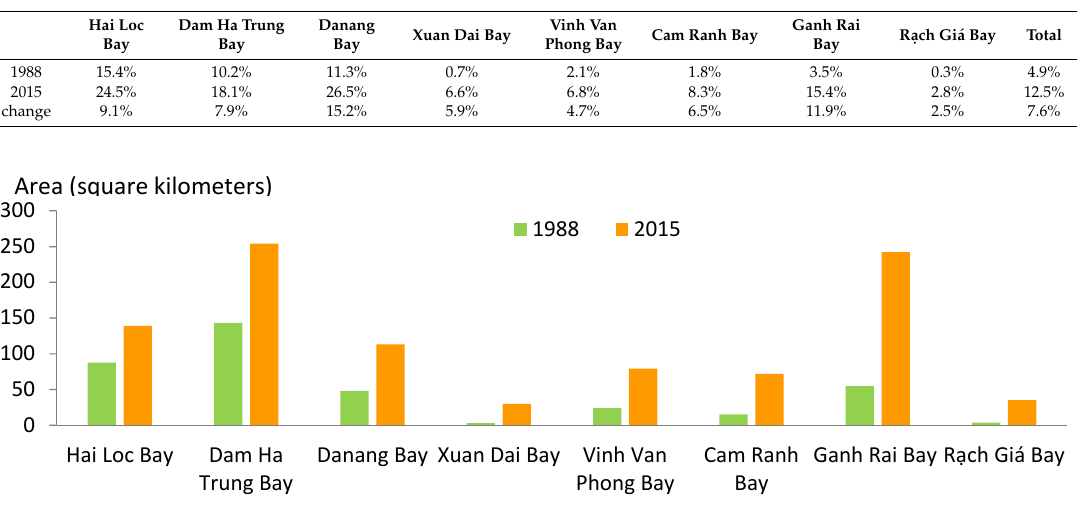
Figure 5. Spatial distribution of construction land in bays. ( a ) Hai Loc Bay; ( b ) Dam Ha Trung Bay; ( c ) Danang Bay; ( d ) Xuan Dai Bay; ( e ) Vinh Van Phong Bay; ( f ) Cam Ranh Bay; ( g ) Ganh Rai Bay; ( h ) R ạ ch Giá Bay. 3.2. Spatial Trends Figure 6 shows the proportions and areas of construction land in each bay. Except for the AIs, the bay-level LPIs, PDs and LSIs in 2015 were greater than those in 1988. This result indicated that the distribution of construction land became more fragmented, and the shape tended to become more complex over 30 years. There was a significant increase in the LPIs of Hai Loc Bay, Dam Ha Trung Bay, Danang Bay and Ganh Rai Bay. In Danang Bay, the LPIs were significantly greater than in the